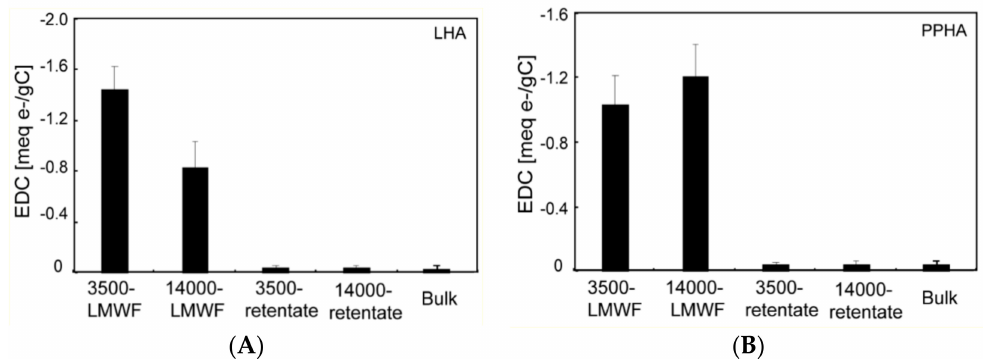
Figure 2. The EDC of different molecular weight fractions of LHA under +0.61 V direct electrochemi- cal oxidation experiments. ( A ) LHA; ( B )